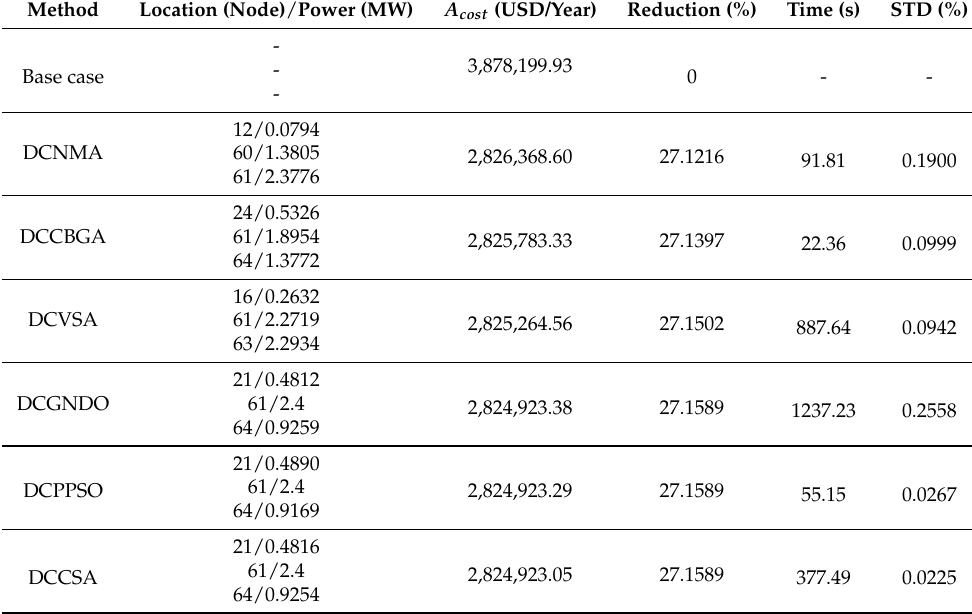
Table 4. Numerical results obtained in the 69-node test system.